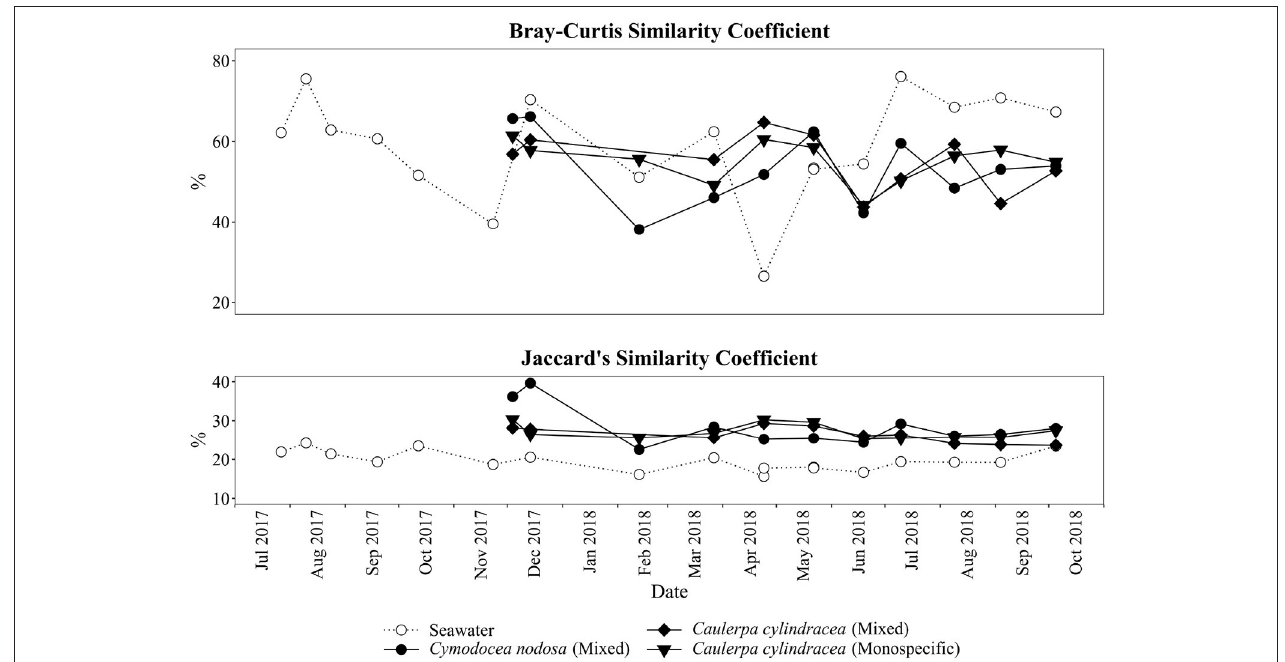
FIGURE 3 | Proportion of shared bacterial and archeal communities (Bray-Curtis similarity coefficient) and shared bacterial and archaeal OTUs (Jaccard’s similarity coefficient) between consecutive sampling dates and from the surfaces of the macrophytes C. nodosa (mixed settlement) and C. cylindracea (mixed and monospecific settlement) and in the ambient